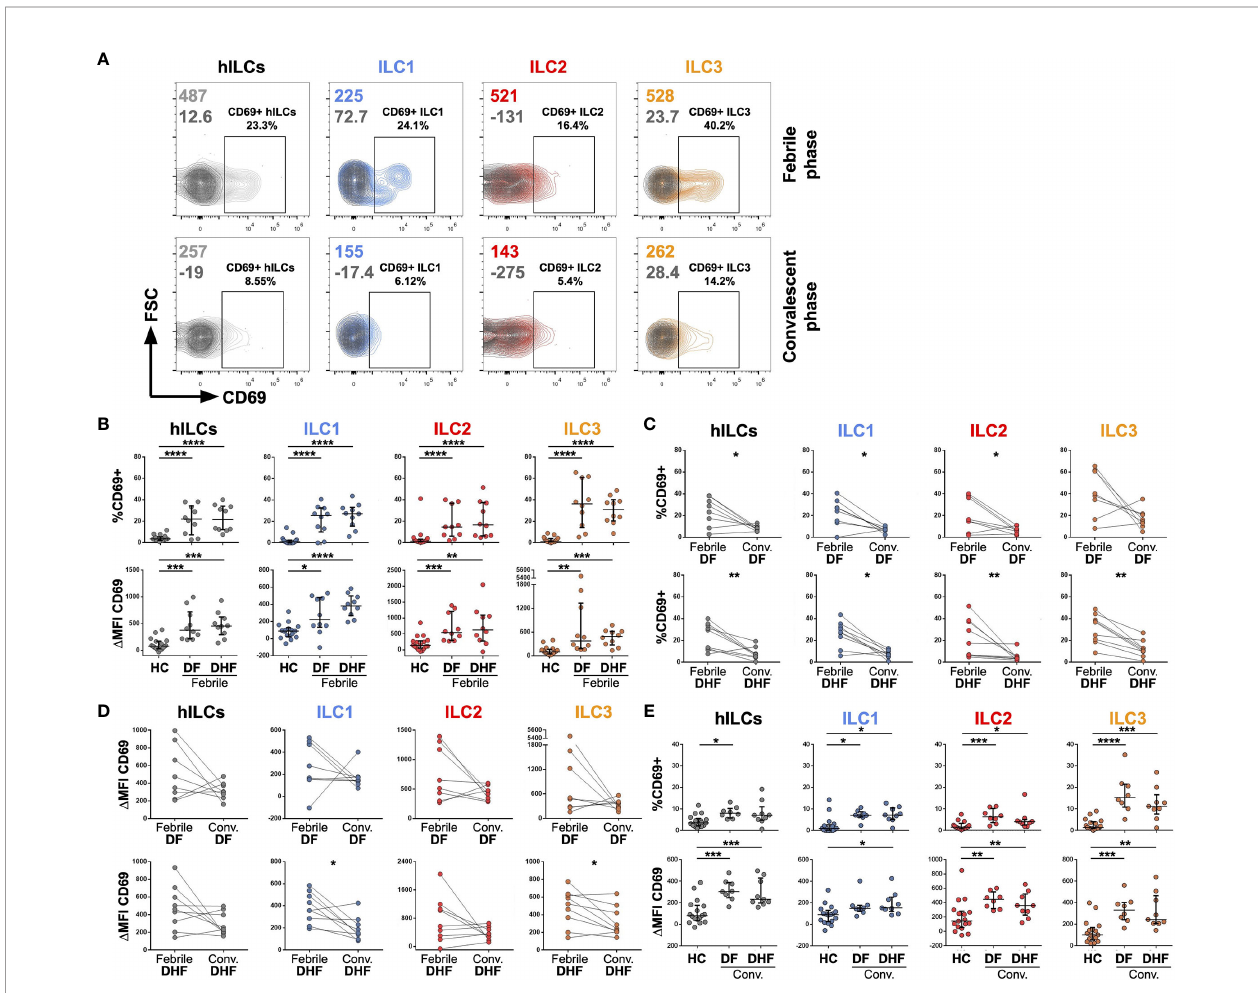
FIGURE 2 | Activation of hILCs during the febrile phase of DENV infection. (A) Representative contour plot of CD69 expression (light grey, blue, red, and orange) as compared with isotype control (dark grey) on total hILC and each hILC subsets in febrile phase and convalescent phases. (B) Percentage of CD69+ (upper panel) and D MFI (CD69 MFI - isotype control MFI) (lower panel) for total hILCs and each hILC subset in febrile phase of dengue fever (DF) patients and dengue hemorrhagic fever (DHF) patients compared to healthy donors (HC). (C) Percentage of CD69+ and (D) D MFI for total and hILC subsets of febrile phase compared to matched convalescent of DF (upper panel) and DHF (lower panel). Each line connected data of the same patient between two timepoints. Wilcoxon matched-pairs signed rank test was used for statistical comparison, p < 0.05 was considered as a statistically signi fi cant difference. (E) Percentage of CD69+ (upper panel) and D MFI (lower panel) for total and hILC subsets in convalescent phase of DF and DHF patients compared to healthy donors (HC). The results were presented as Median ± IQR. Data were analyzed using Mann-Whitney test (B, E) or Wilcoxon matched-pairs signed rank test (C, D) (* p < 0.05, ** p < 0.01, *** p < 0.001, ****p <